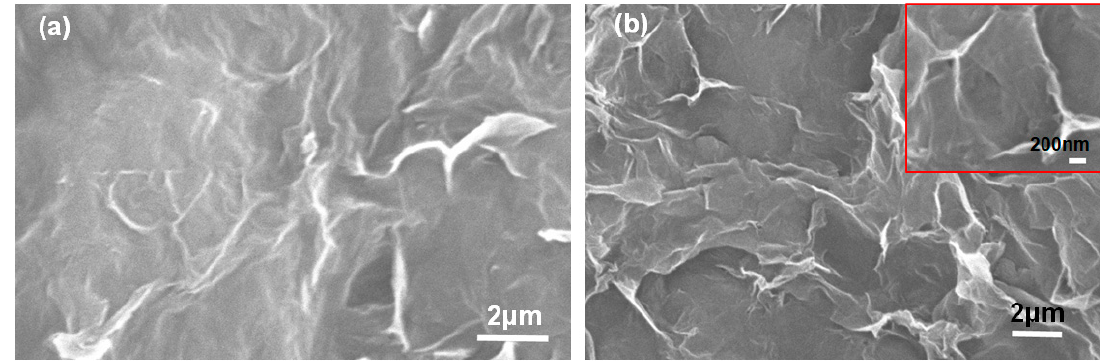
Figure 18. Surface morphology of the membrane with 50 wt.% graphene ( a ) before and ( b ) after the electric heating test.